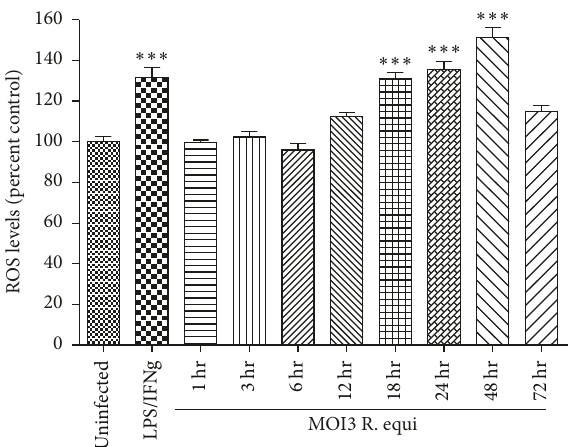
Figure 2: R. equi infection of BMDM led to an increase in ROS. BMDM were uninfected or infected with R. equi (moi3) for 1h, 3 h, 6h, 18h, 24 h, 48 h, and 72 h. Stimulation of BMDM with a combination of 10 𝜇 g/ml LPS and 25 ng/ml IFN 𝛾 (24 h) is used as a positive control. R. equi infection led to an increase in ROS as measured using a ROS indicator, CM-H2DCFDA (30 min). Data represent mean ± SEM of 6 independent measurements. ∗∗∗ 𝑝 < 0.001